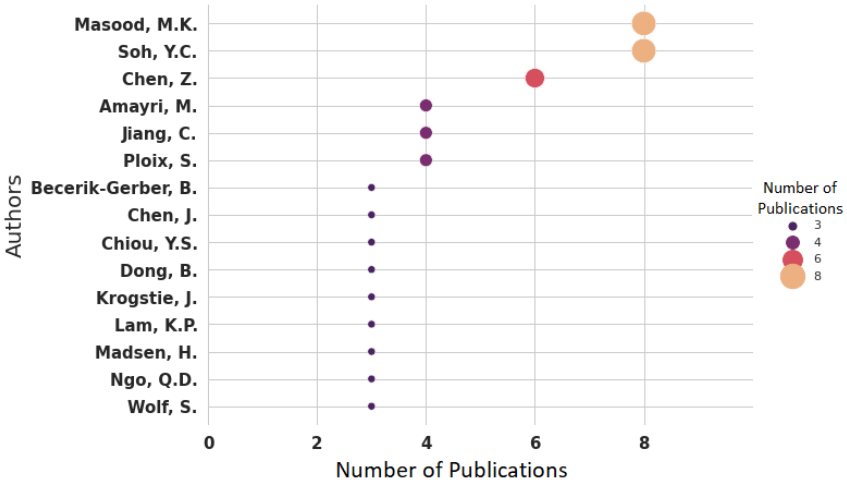
Figure 6. Publications on indoor occupancy estimation by author.